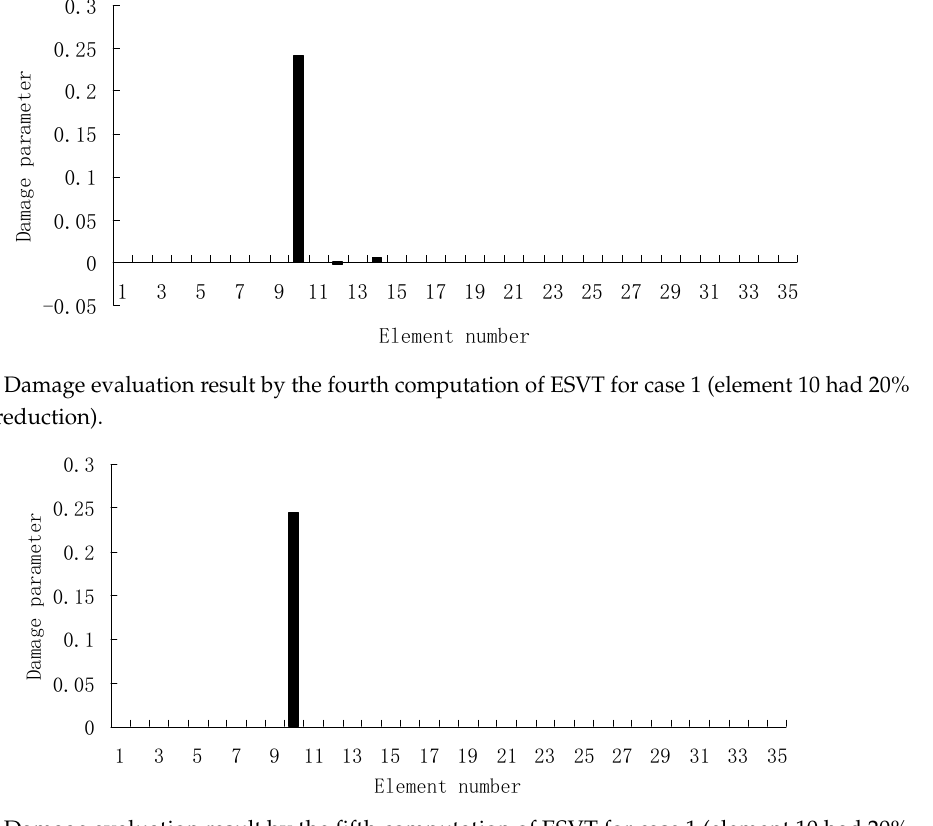
Figure 8. Damage evaluation result by the fifth computation of ESVT for case 1 (element 10 had 20% stiffness reduction).